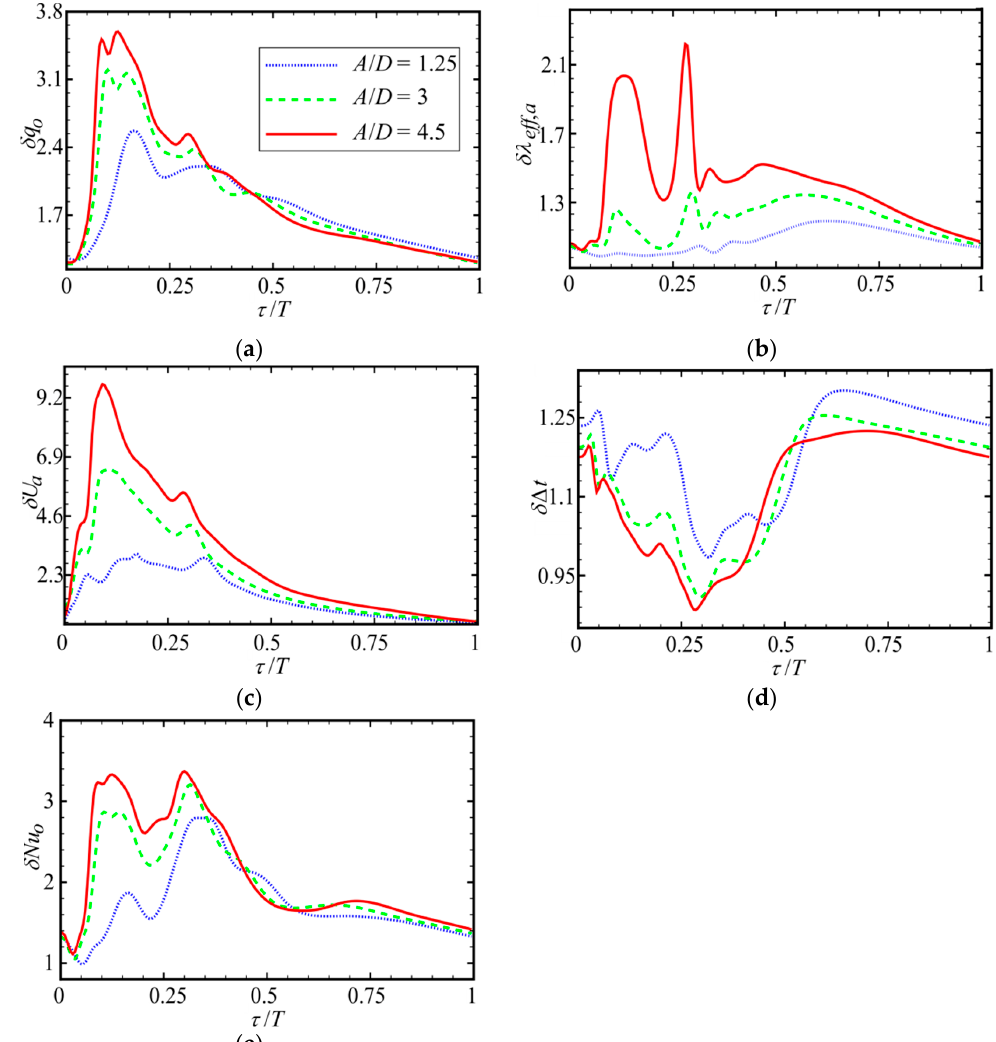
Figure 9. The effect of pulsations on instantaneous flow and heat transfer characteristics averaged over space at f = 0.5 Hz for one period of pulsation. ( a ) Variation of heat flux ratio δ q o = q o , p / q o , st with τ / T . ( b ) Variation of effective thermal conductivity ratio δλ eff , a = λ eff , a , p / λ eff , a , st with τ / T . ( c ) Variation of velocity ratio δ U a = U a , p / U a , st with τ / T . ( d ) Variation of temperature difference ratio δ ∆ t = ∆ t p / ∆ t st with τ / T . ( e ) Variation of Nusselt number ratio δ Nu o = Nu o , p / Nu o , st with τ / T